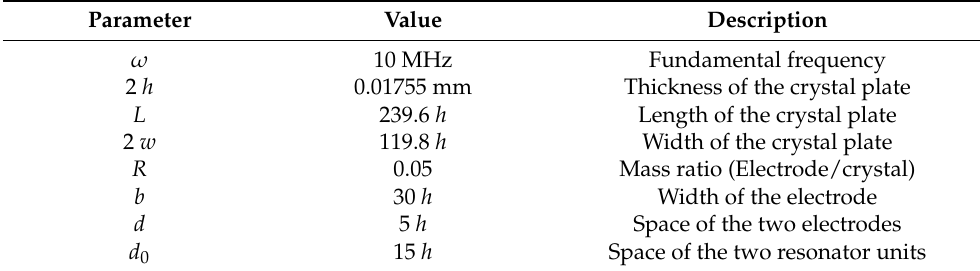
Table 1. Parameter